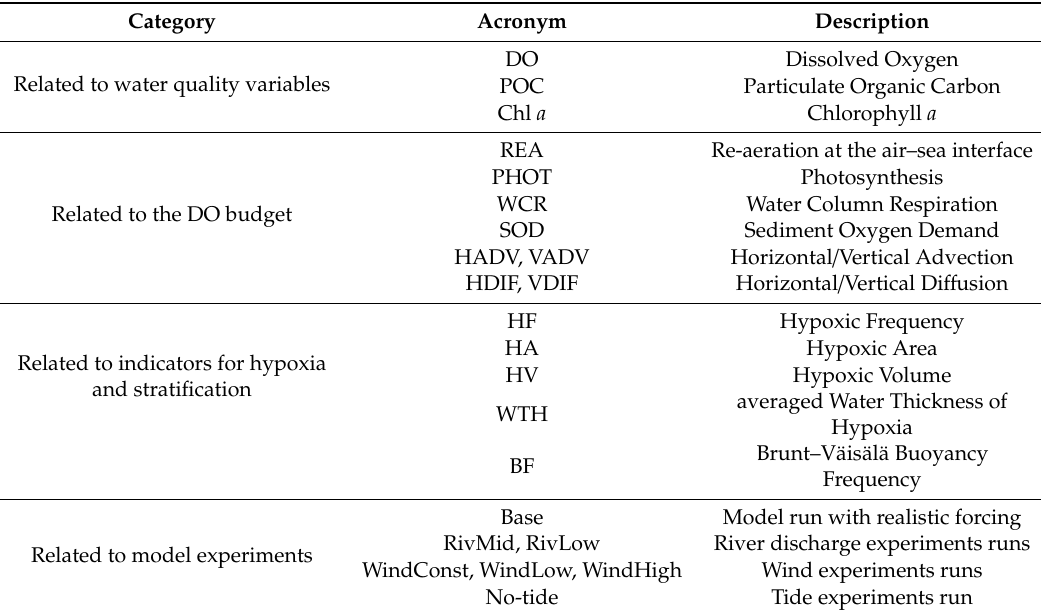
Table A1. List of main acronyms and descriptions in this